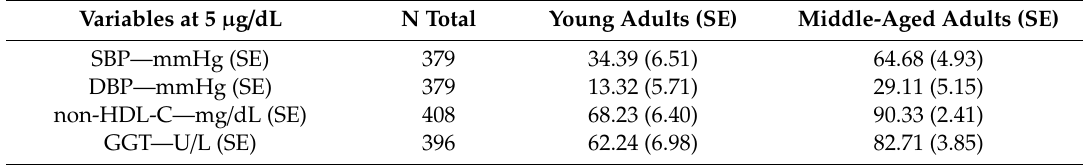
Table 3. Percentage of adults above the clinical threshold for the markers of interest.